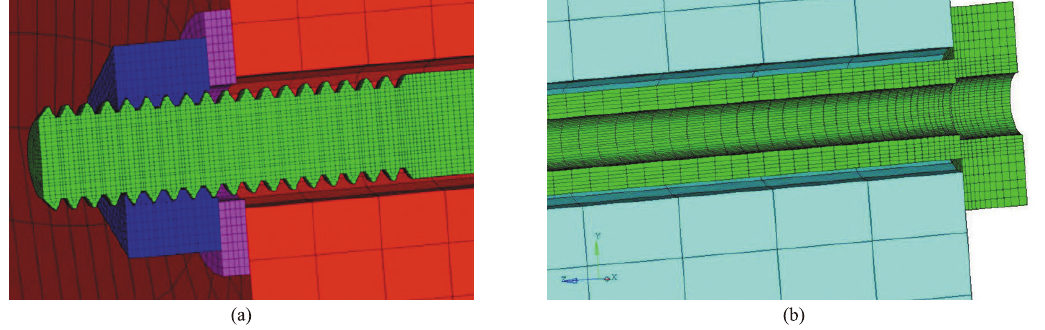
Fig. 4. Section views of static tension finite element model, details of (a) threaded end; and (b) bore and counterbore at